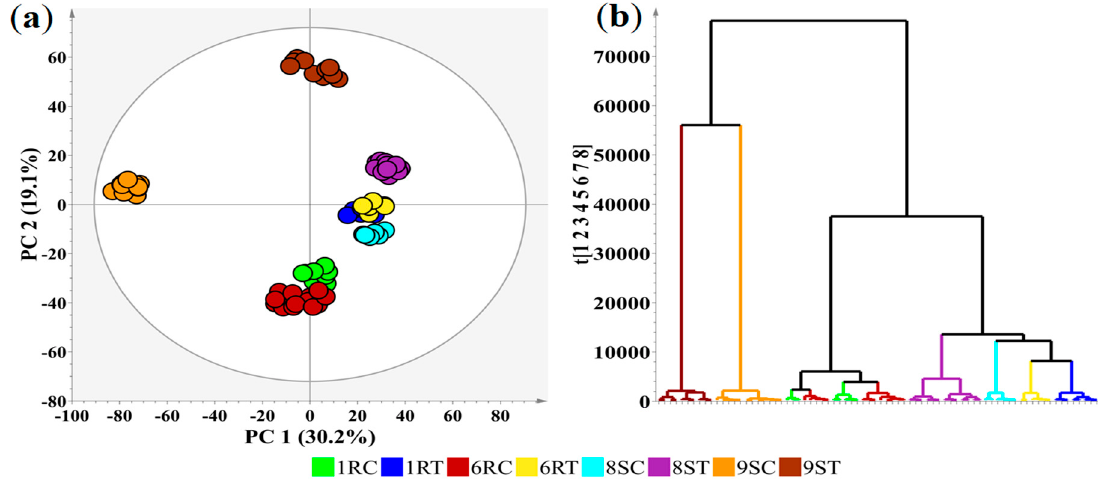
Figure 2. A PCA score plot of the UHPLC-MS ESI( − ) data of the extracts prepared from the leaves of four Solanum lycopersicum cultivars treated with Ralstonia solanacearum . The labels C and T refer to the control and treatment of the four cultivars (1R, 6R, 8S, and 9S) with varying resistance (R) or susceptibility (S) to the pathogen. ( a ) A 2D principal component analysis (PCA) score plot illustrating the grouping of the variable conditions. The ellipse on the score plot represents Hoteling’s T2 with a 95% confidence interval. ( b ) A single-linkage hierarchical cluster dendrogram corresponding to ( a ), showing the hierarchical outline of the leaf data of the cultivars before and after treatment.